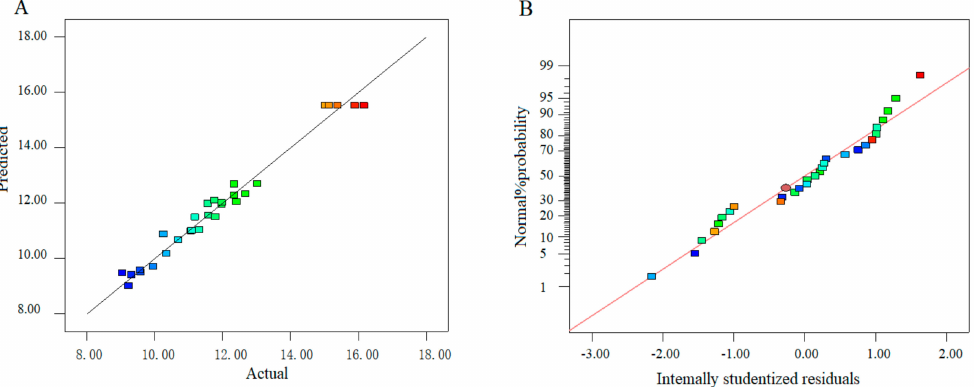
Figure 2. Plots of the adequacy about the proposed model. Plot of the predicted and actual values ( A ); the normal% probability plot ( B